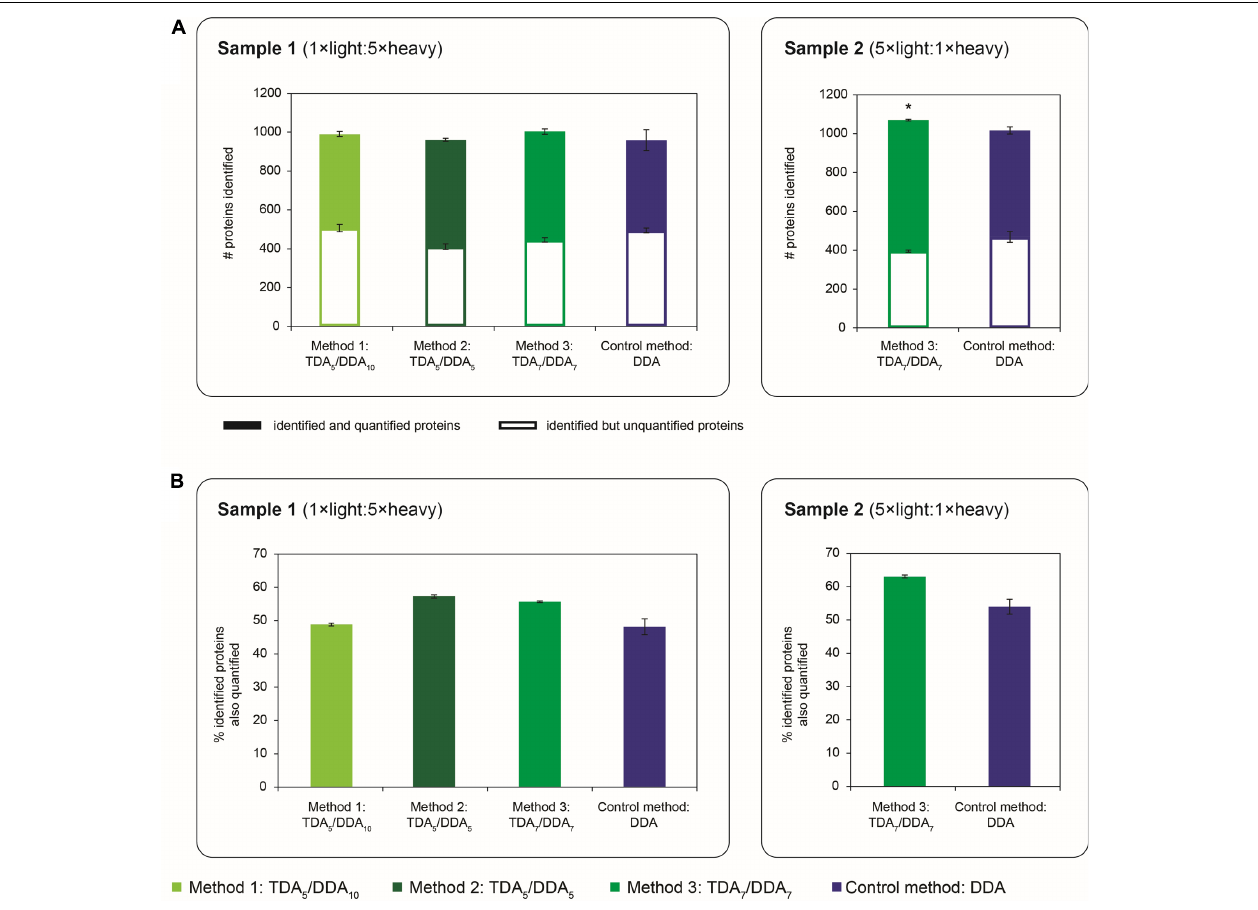
FIGURE 6 | Quantity of proteins identified and quantified in TDA/DDA and DDA control method experiments. (A) Average numbers of proteins identified (from ≥ 2 significantly scoring peptide spectrum matches) per technical replicate in each batch of LC-MS/MS experiments conducted on sample 1 (left) and sample 2 (right); identified and quantified proteins are differentiated from proteins that are identified but not quantified; standard errors are shown for these two categories of identified protein. (B) Average percentages of identified proteins that are also quantified (from ≥ 2 heavy/light peptide pairs) per technical replicate in each batch of LC-MS/MS experiments conducted on sample 1 (left) and sample 2 (right). Statistically significant differences between TDA/DDA and DDA control method experiments, as determined using 2-tailed t -tests, are labeled ∗ p <